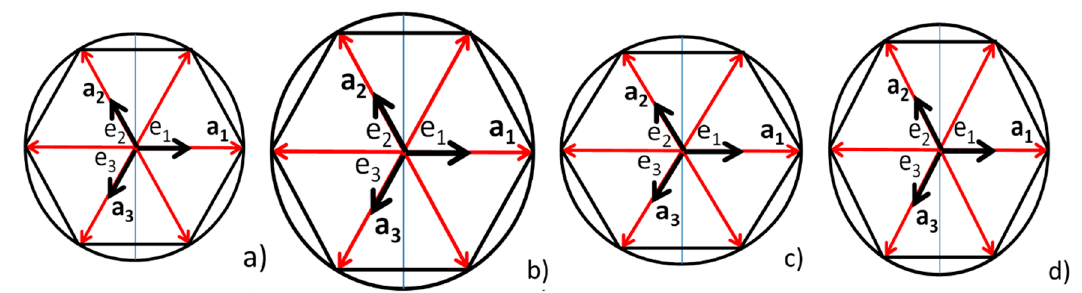
Figure 7. ( a ) Fundamental 4HSiC cell; ( b )